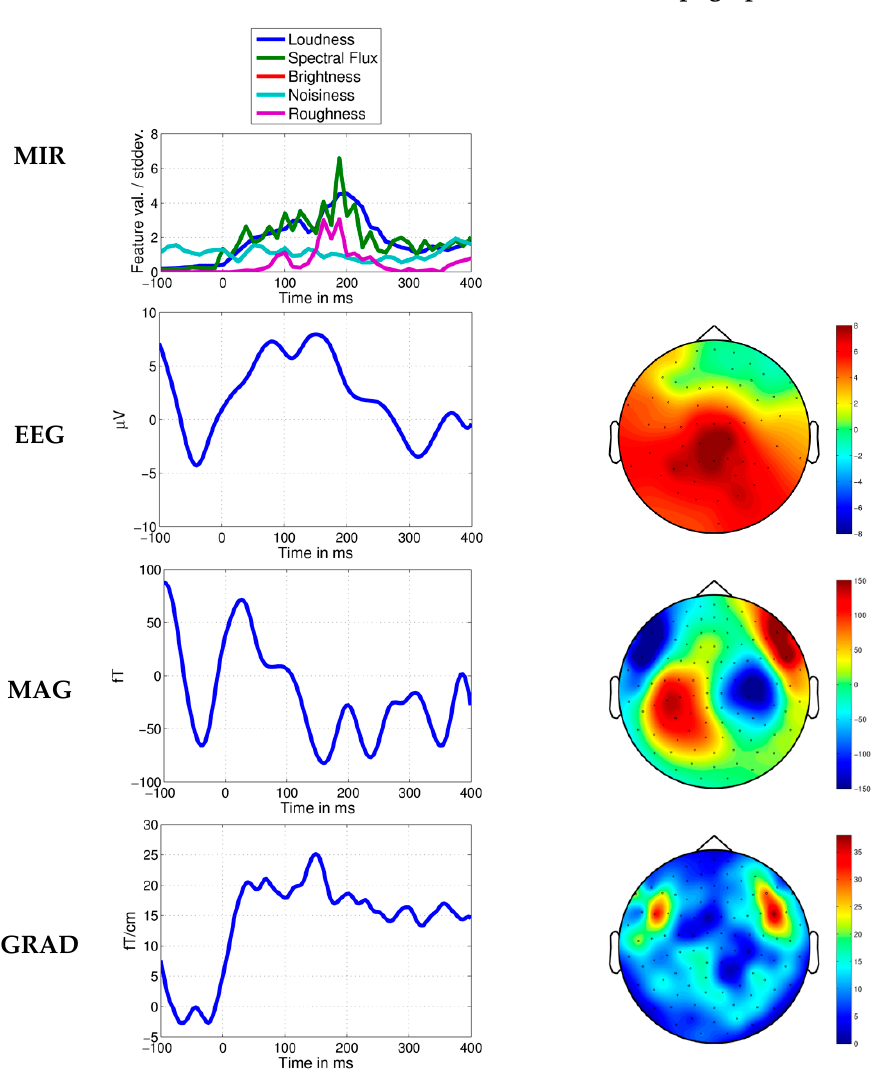
Figure 7. Response to the ‘Augurs’ chord in Stravinsky’s Rite of Spring . Average MIR feature values per standard deviation, EEG, MEG axial magnetometer (MAG) and MEG planar gradiometer (GRAD) waveforms shown 100 ms before and 400 ms after the time point at 198.646 s. Topographies in relation to the head are shown for the anterior MMN/ERAN-like brain response measured in a time window of ±15 ms around the peak. The MEG topographies suggest that frontal-central brain regions are involved in the response.